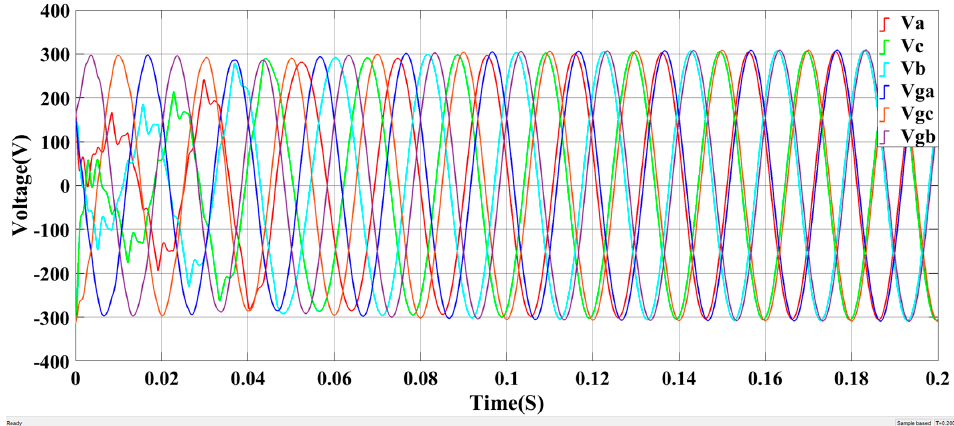
Figure 16. An output voltage comparison diagram between the inverter and the power grid under the traditional PLL algorithm.